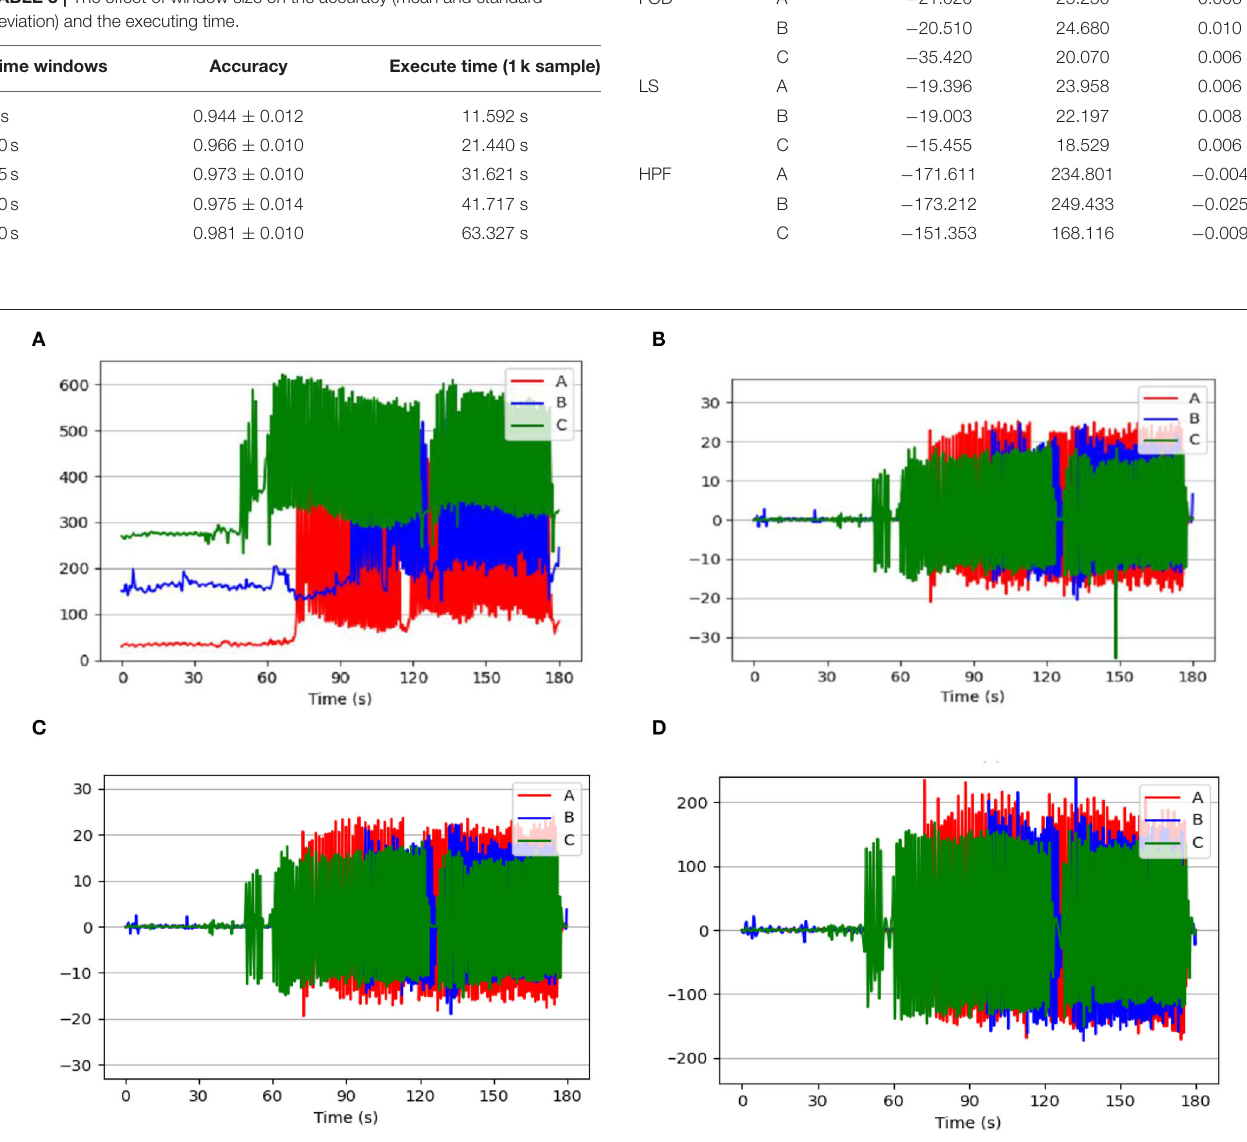
FIGURE 4 | Graph of data pretreatment algorithm. Sample A, sample B, and sample C come from three different cattle. (A) Raw pressure data. (B) Data processed by the first-order difference method (FOD). (C) The local slope (LS) of raw data. (D) Data processed after the high-pass filter (HPF).